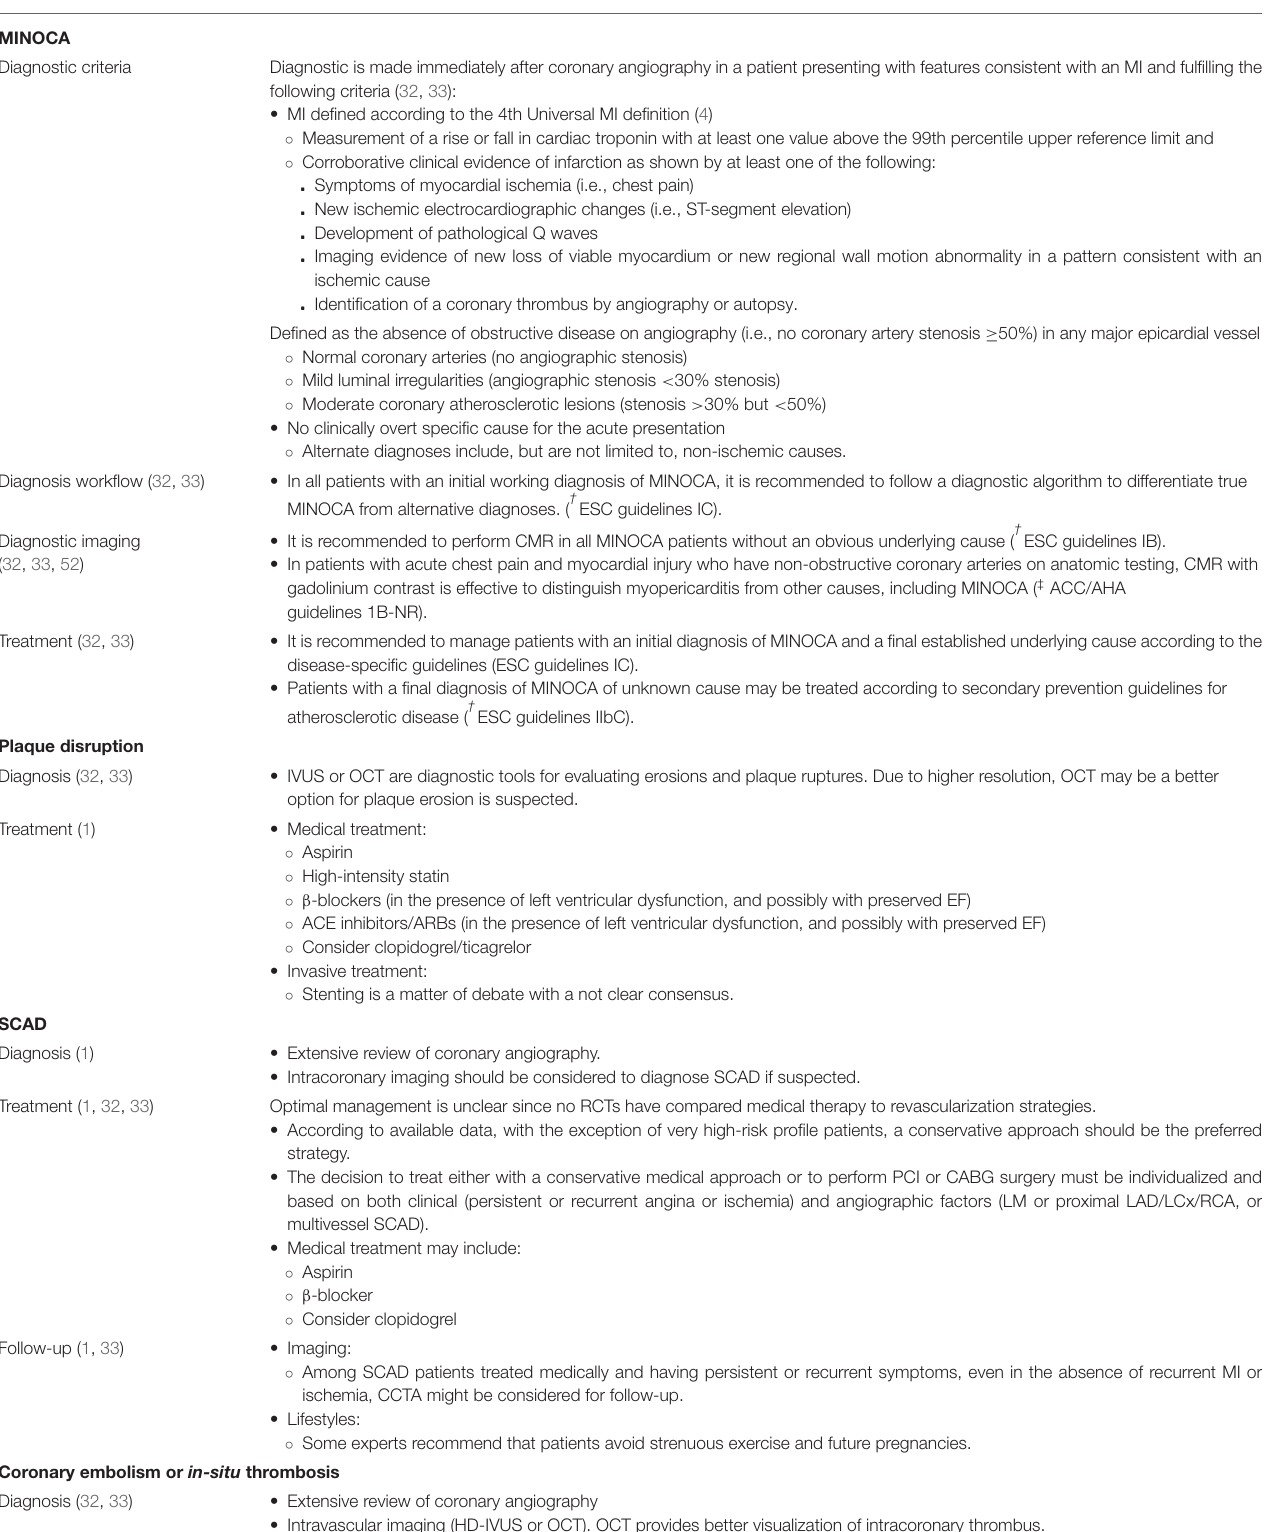
TABLE 1 | Current clinical guidelines